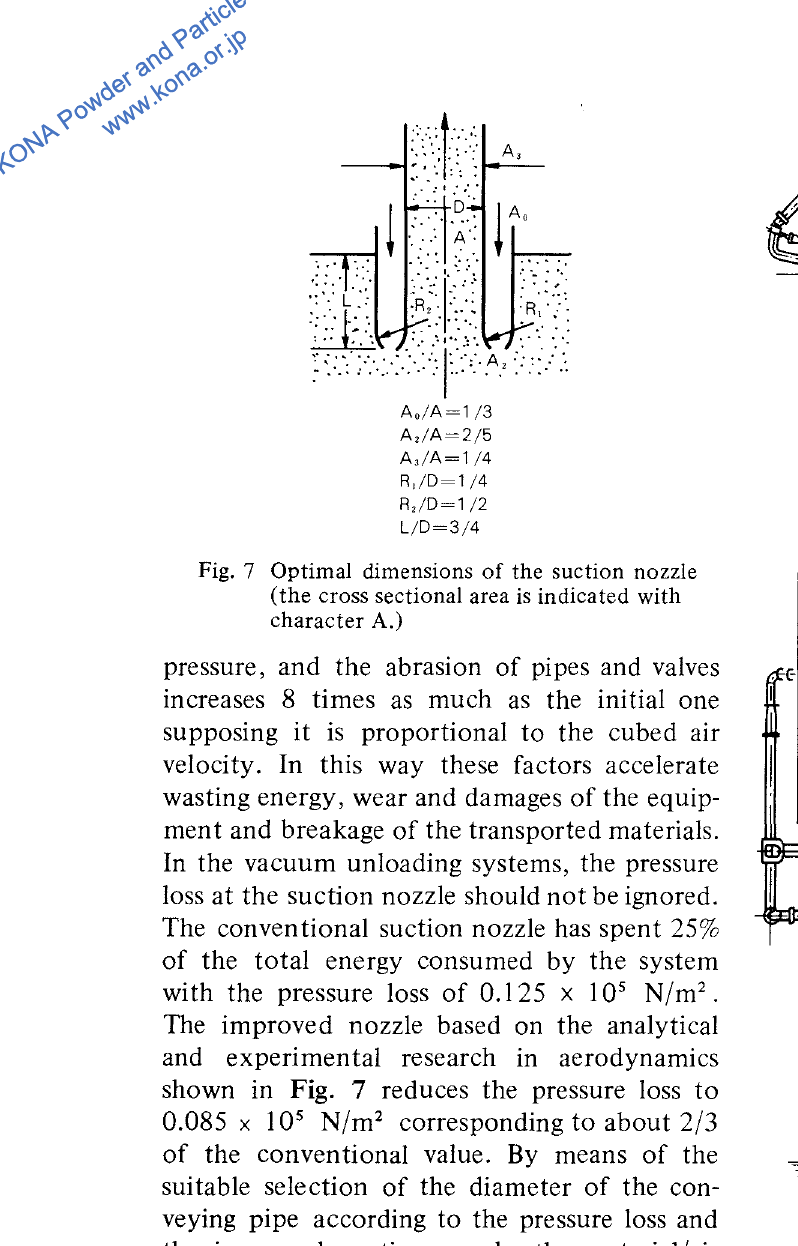
Fig. 8 Dual type blow tank system